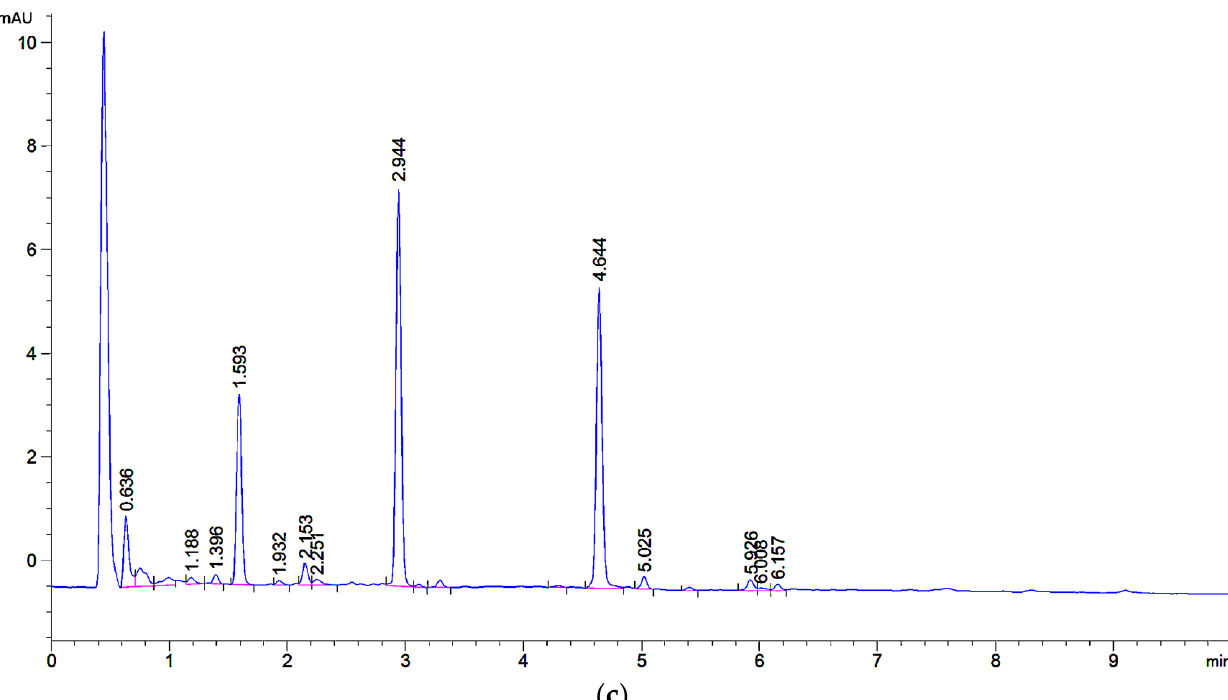
Figure 4. UHPLC profiles of extracted wool samples ( a ). extract of 56.6 µ g weld-dyed wool. ( b ). extract of 49.2 µ g weld-dyed wool. Peak numbers refer to Figure 1. ( c ). extract of 28.3 µ g of onion-dyed wool.